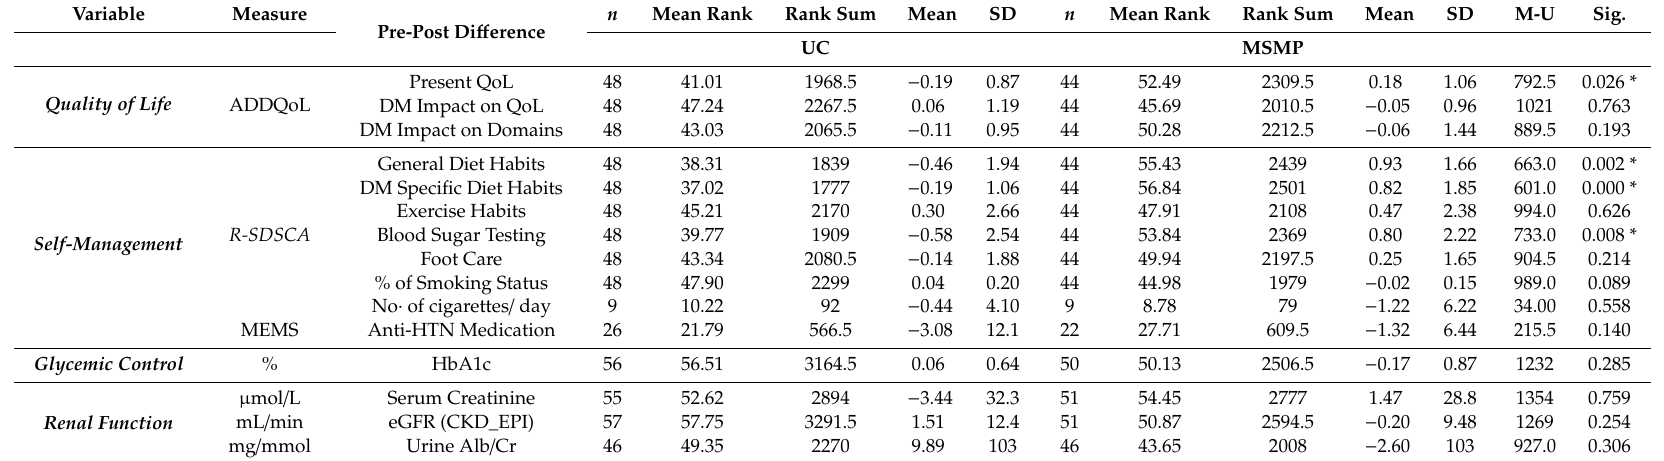
Table 4. Changes in quality of life (QoL), Self-Management, Glycemic Control, and Renal Function between MSMP and usual care